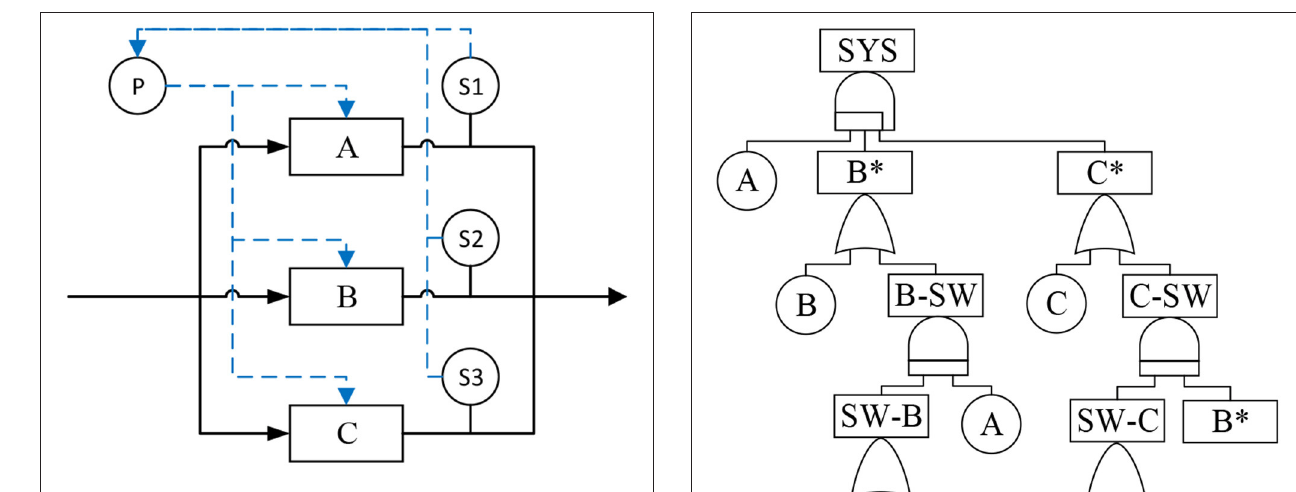
FIGURE 4 | Example of a Triple-redundant system.